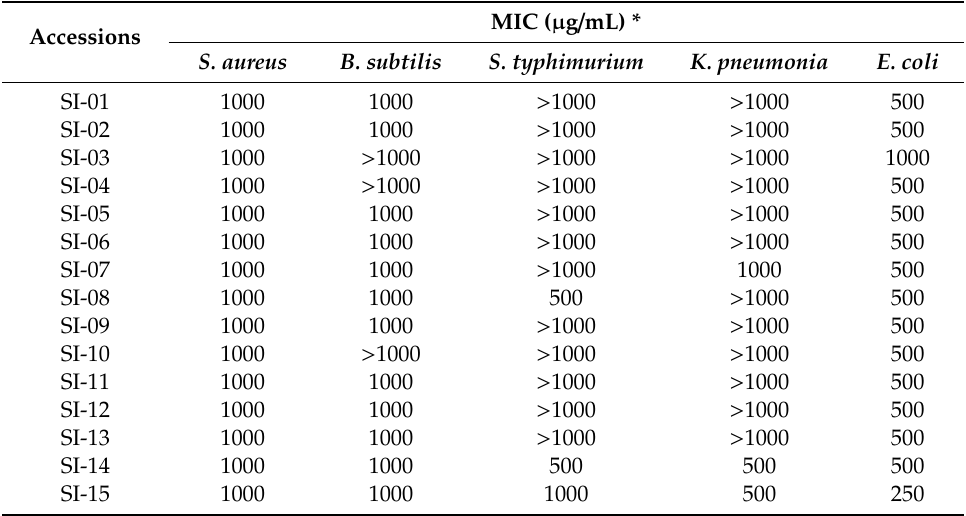
Table 8. Antimicrobial activities of the selected accessions of S. italica